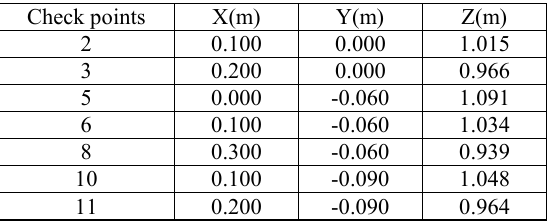
Table 3. The coordinates of the check points